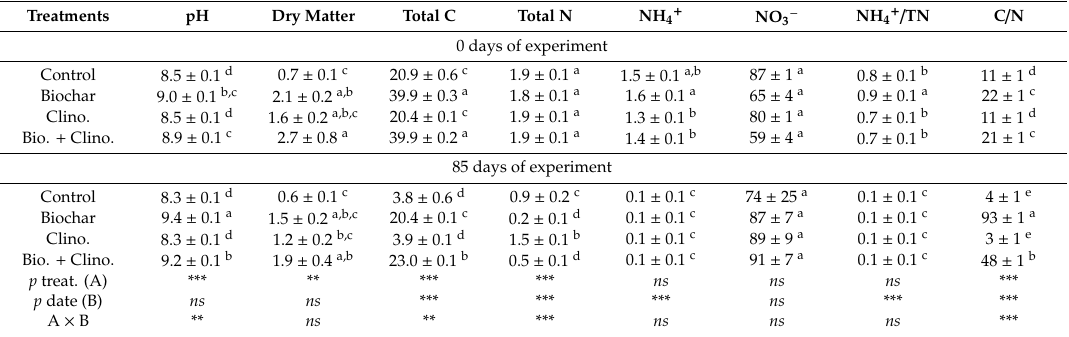
Table 1. Physicochemical characteristics of the treatments at the beginning and end of the experiment (mean ± standard deviation) ( n = 3).